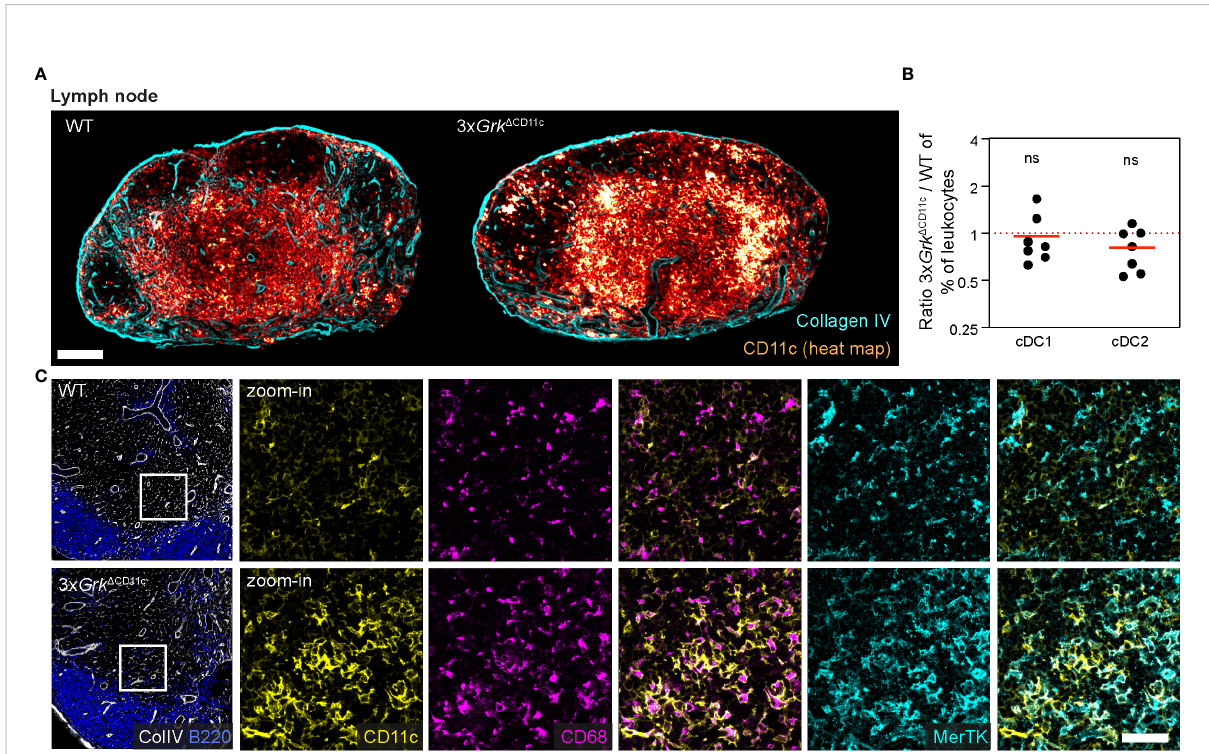
FIGURE 7 Complete GRK depletion impairs DC differentiation in the lymph node. (A) Representative images of CD11c-expressing cells (glow heat map displays signal intensity) in inguinal lymph nodes of 3x Grk D CD11c and littermate control mice. Collagen IV (cyan) is displayed for orientation. Scale bar: 200 µm. (B) Quanti fi cation of lymph node DC subsets compared to all leukocytes by fl ow cytometry. Displayed are ratios 3x Grk D CD11c versus WT. n = 7 mice per genotype. Bars display the mean. ns nonsigni fi cant, one sample t test. (C) CD68 (magenta) and MerTK (cyan) expression in the T cell area of 3x Grk D CD11c and WT LNs in comparison to CD11c (yellow). B220 (blue) and colIagen IV (white) are displayed for orientation. Scale bar: 40